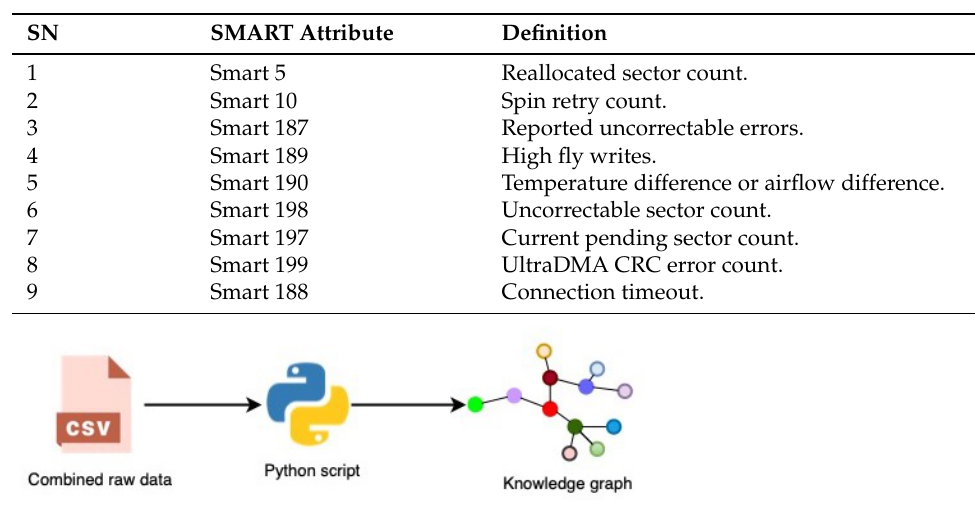
Figure 3. Transforming CSV data into a